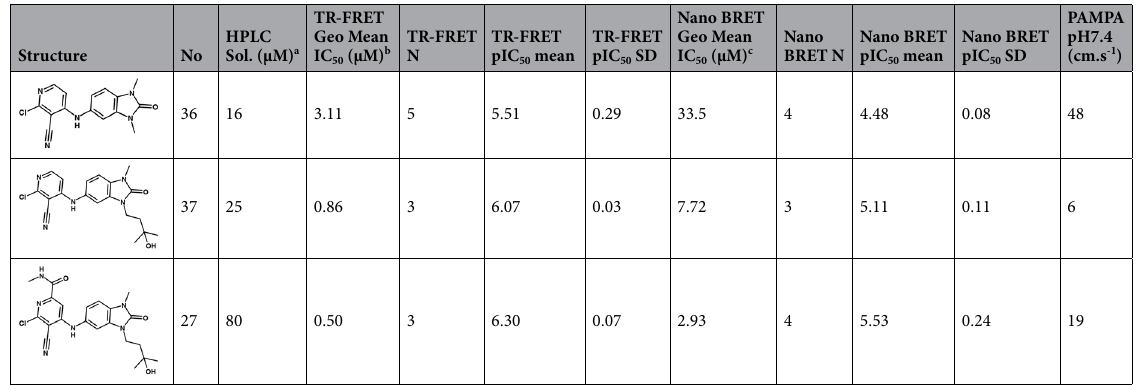
Table 1. Biochemical and cellular activity of benzimidazolones at early-stage optimisation. a Aqueous solubility measured by HPLC in PBS buffer pH 7.4 and 1% DMSO, at maximum targeted concentration of 100 µM. b TR-FRET measured in presence of 1 nM BCL6 BTB domain. Data represents the geometric mean from n = 3–5 replicates. c NanoBRET assay using configuration illustrated in Fig. 7C. Data represents the geometric mean from n = 3–4 replicates.